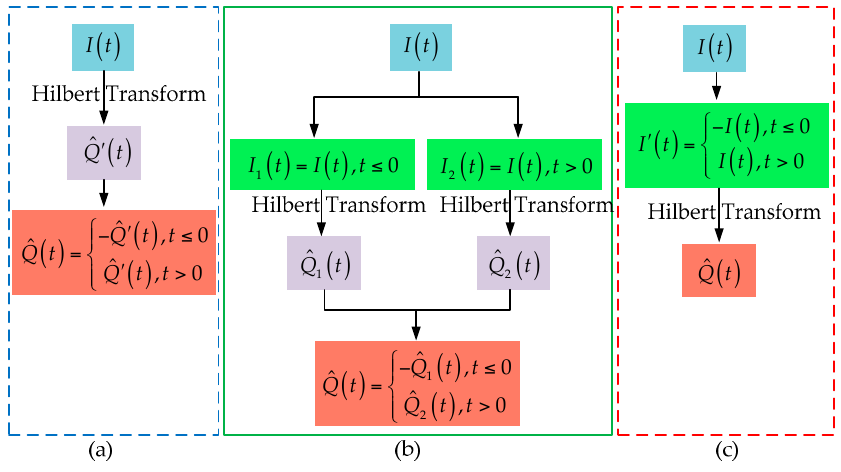
Figure 4. Three ways of segmented Hilbert transform: ( a ) Approach 1; ( b ) Approach 2; ( c ) Approach 3.